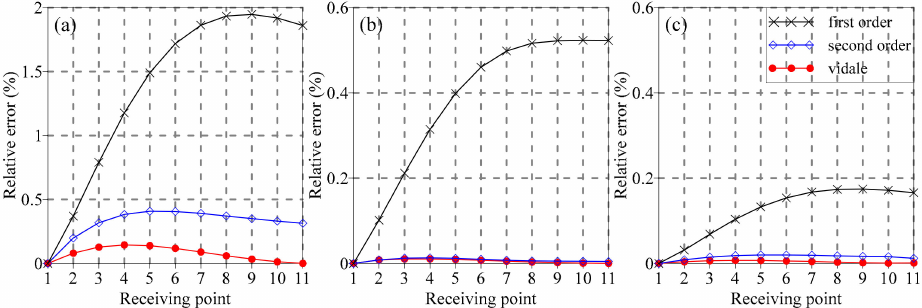
Figure 5. Comparison between the analytical raypath and the numerical raypath of FMM with ( a ) first-order, ( b ) second-order and ( c ) Vidale finite-difference scheme with the grid spacing of 1.0 m. The gray triangle (cid:78) represents the source, and the gray inverted triangle (cid:72) represents the receiving points.